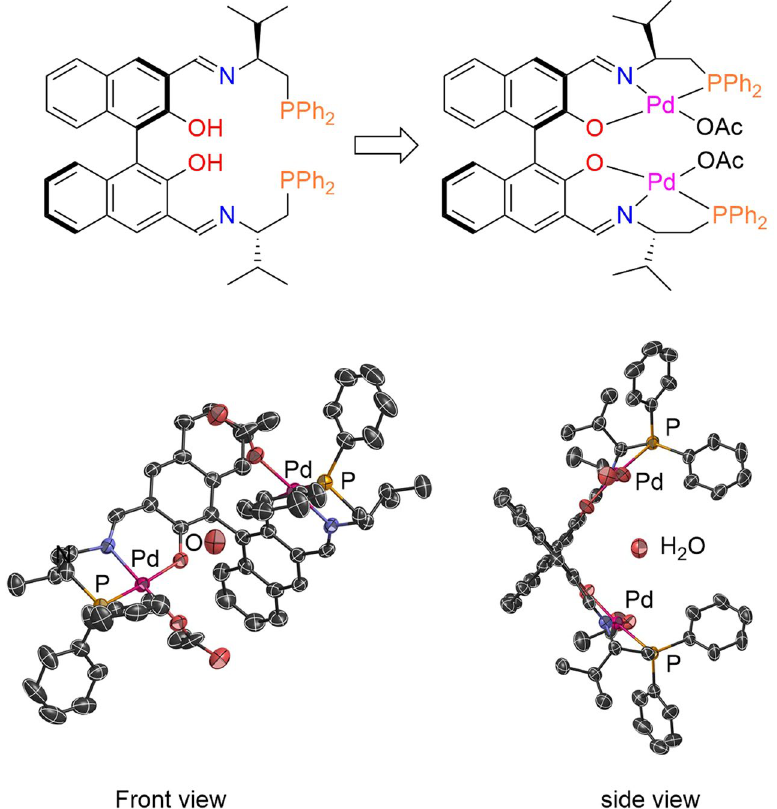
Figure 3. X-ray structure of L1 -Pd 2 (CCDC 1543349).